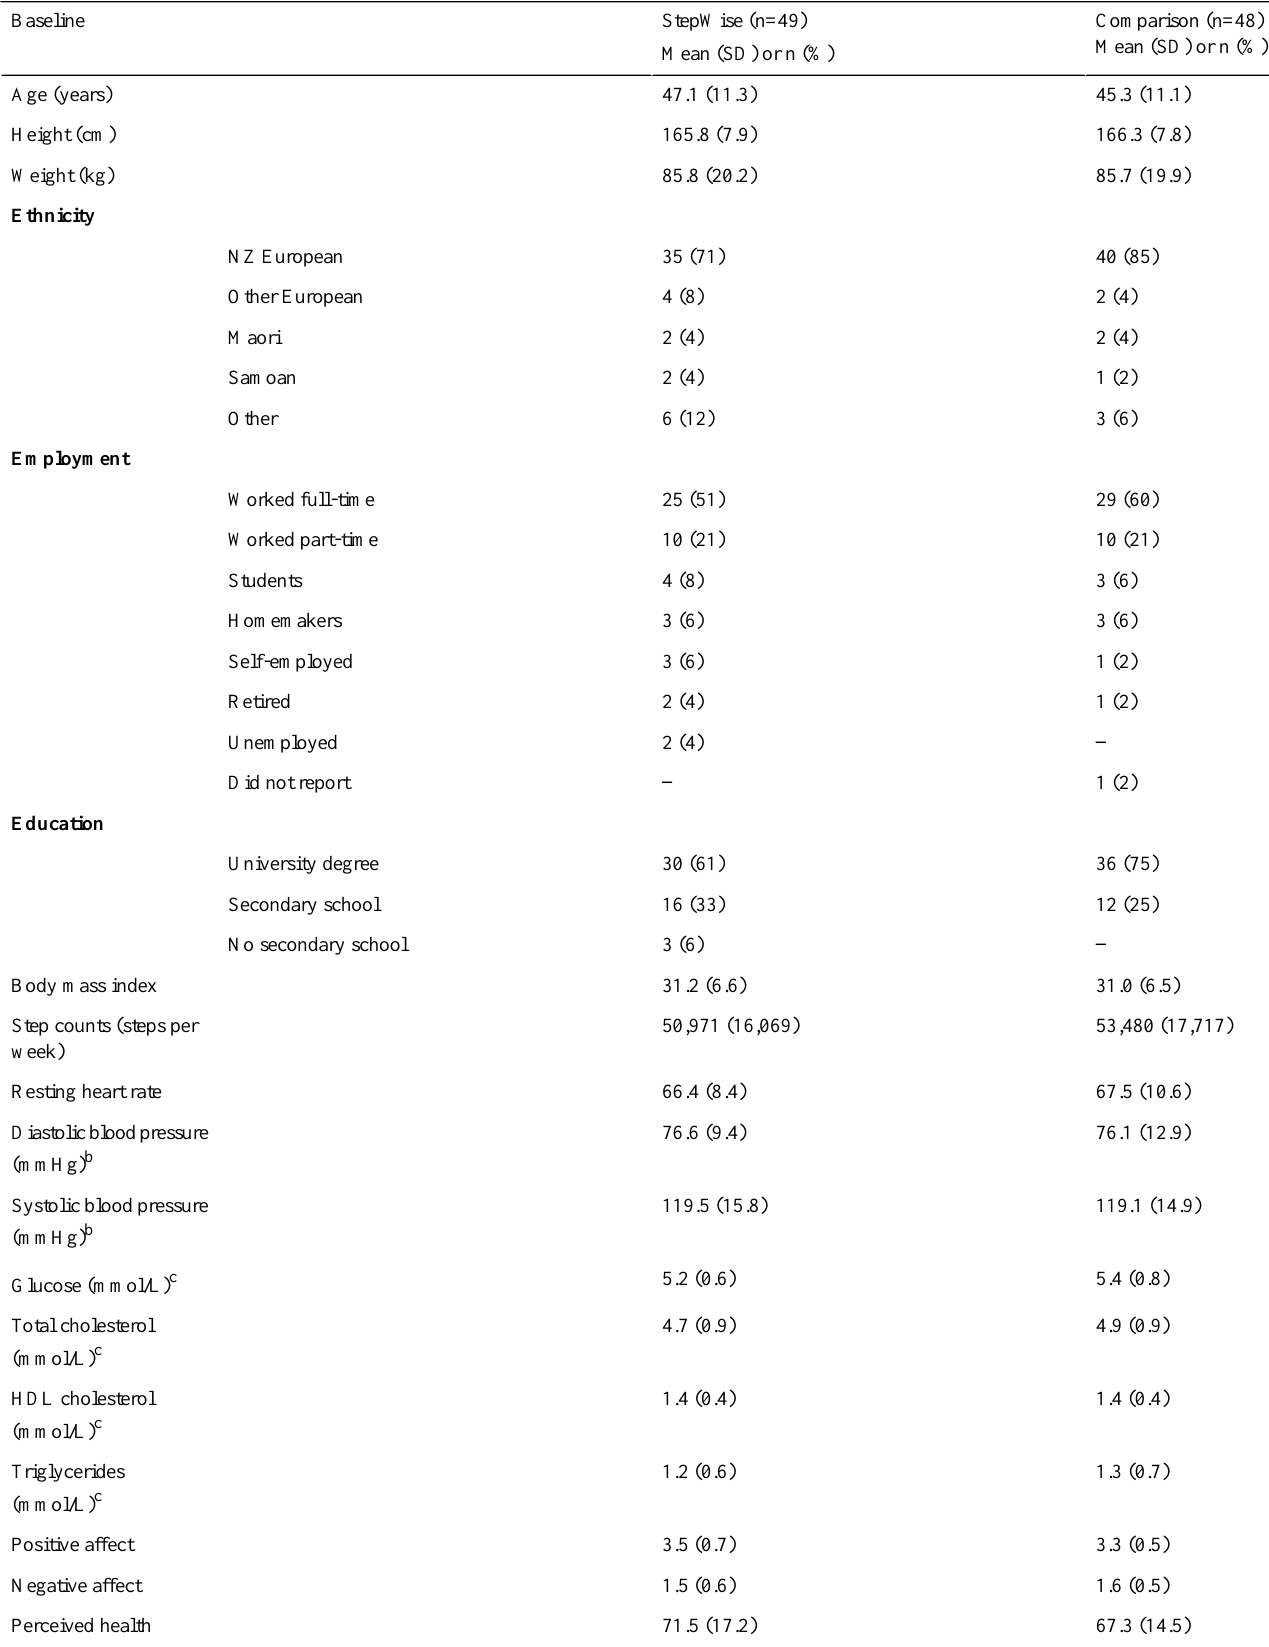
Table 1. Participant baseline characteristics a